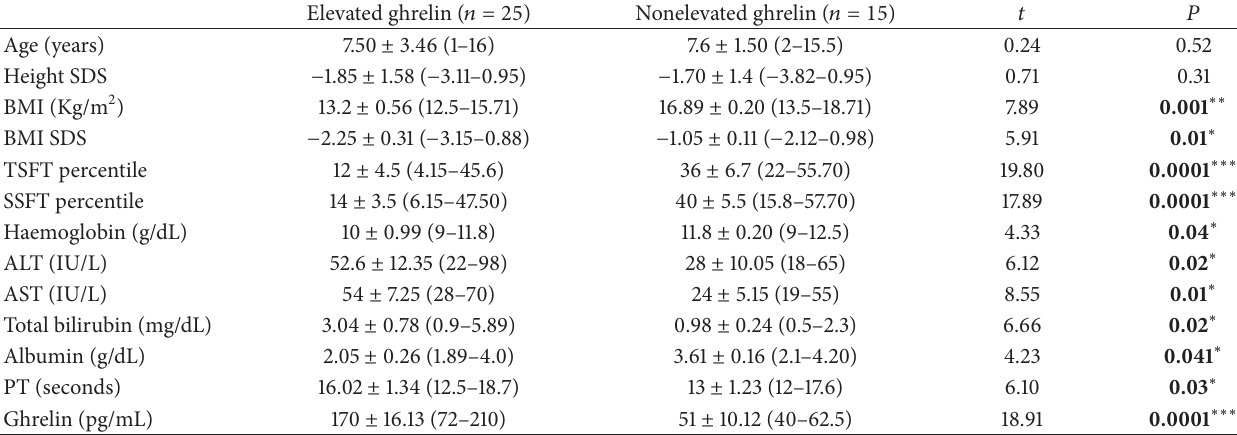
Table 3: Clinical and laboratory data among cases with normal versus elevated serum ghrelin.